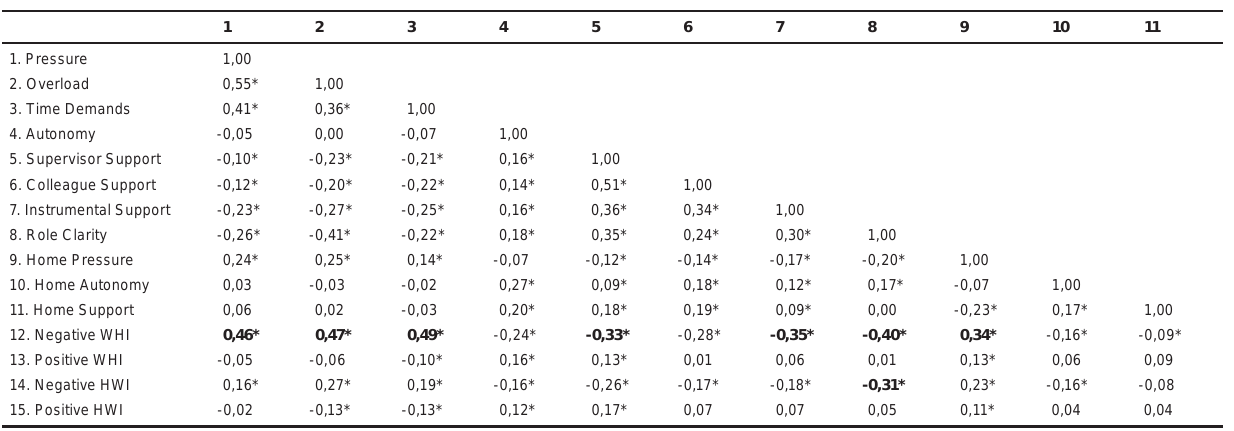
taBLe 3 Product-moment correlations of the constructs